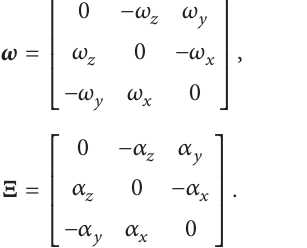
Figure 1: 𝑖 th closed-loop kinematic chain of the Hexaglide.